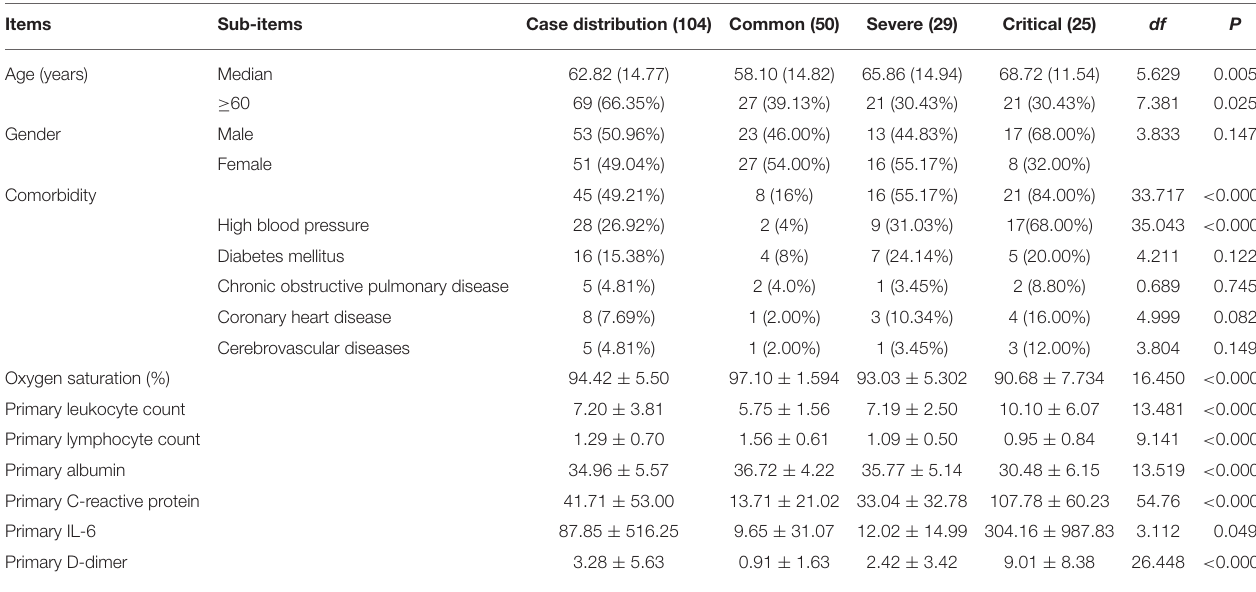
TABLE 1 | The clinical information of the 104 COVID-19